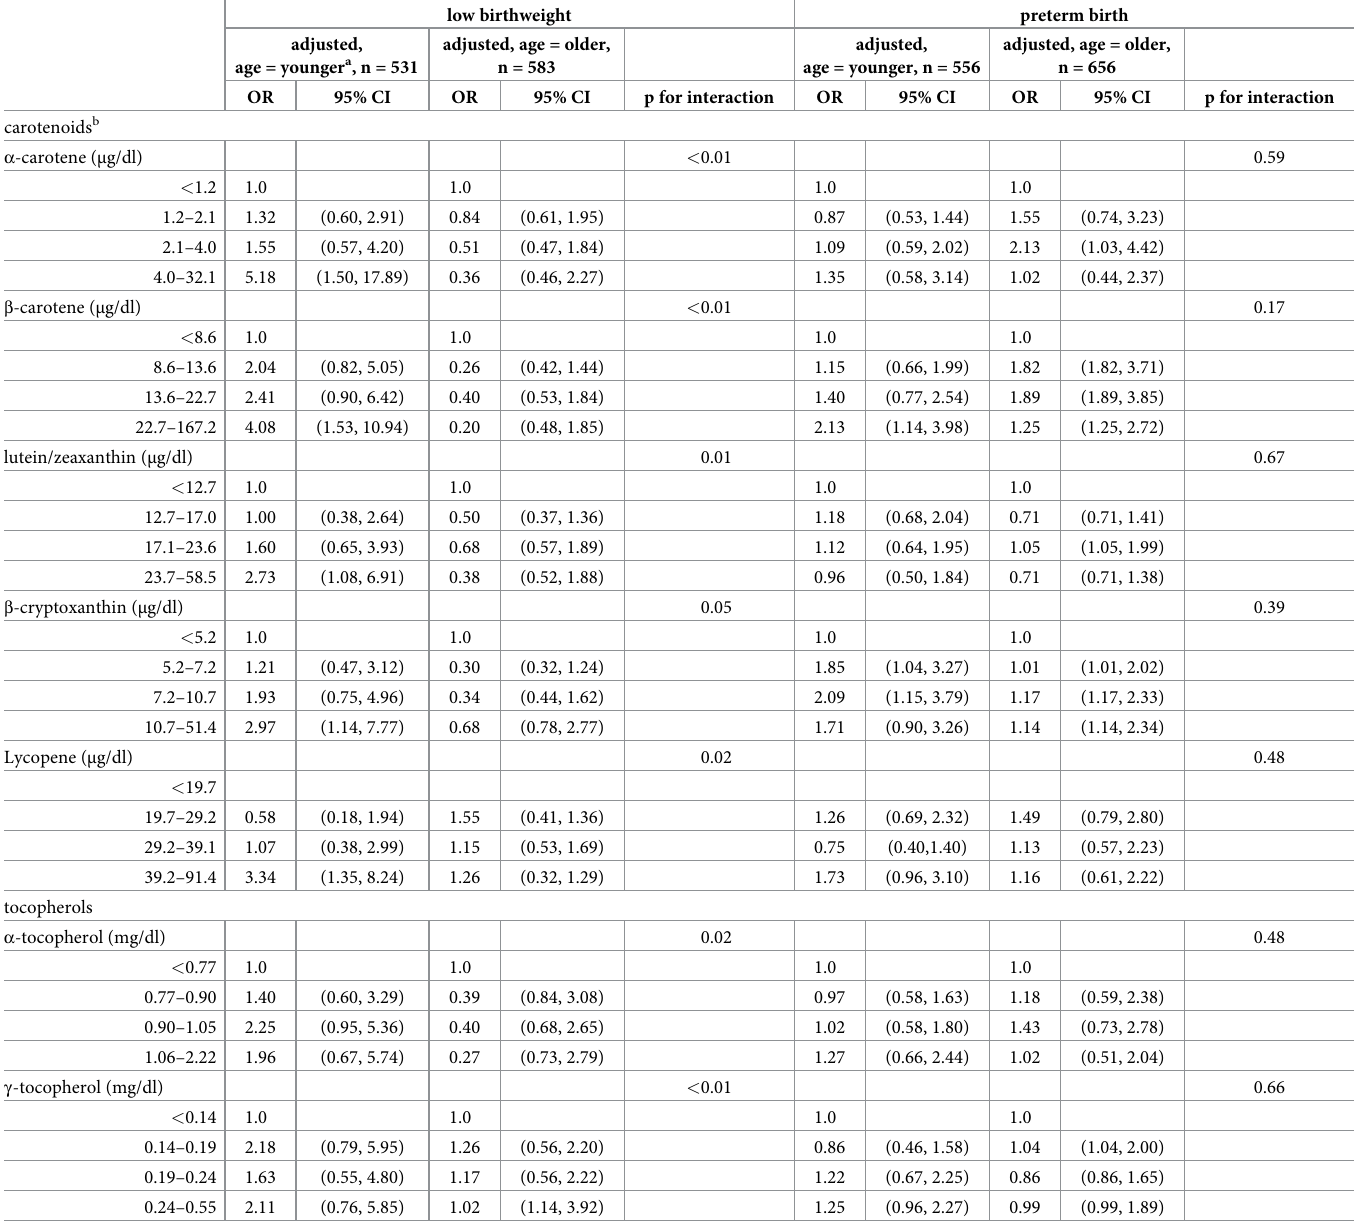
Table 4. Relationship between serum antioxidant status, as quartiles, and subsequent birth outcome, stratified by age. low birthweight preterm birth adjusted, adjusted, age = older, age = younger a , n = 531 n =